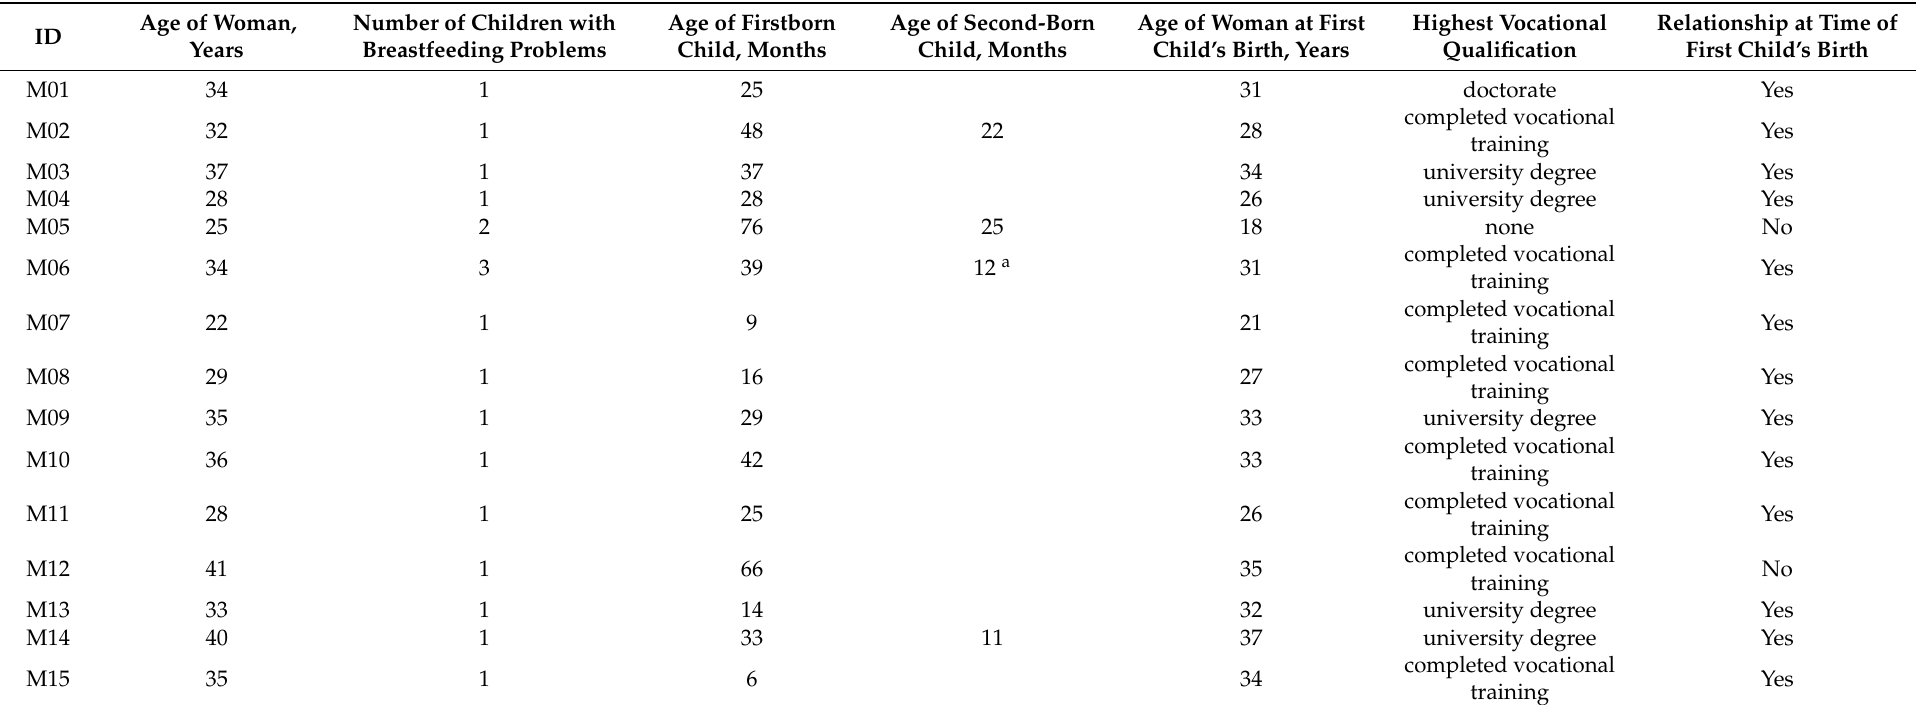
Table 1. Demographic Characteristics of the Participating Women Who Reported Problems in Breastfeeding for at Least One of Their Children ( n =